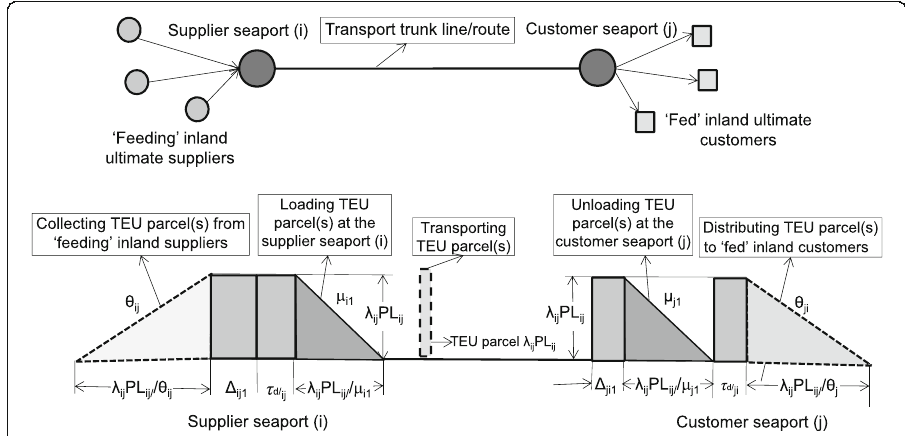
Fig. 3 A simplified scheme of the trunk line/route of a liner shipping network serving an intercontinental supply chain (Jani ć